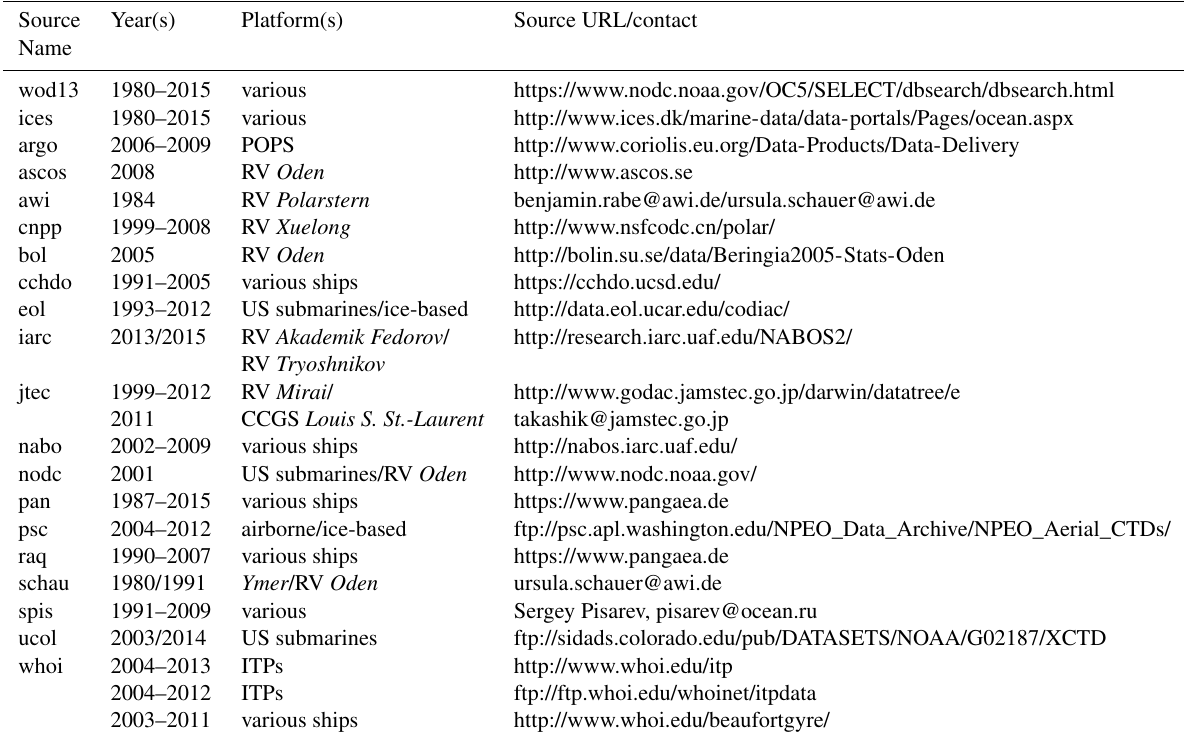
Table 1. Data sources and their abbreviations used in the data files. Also shown are time periods and URLs of the downloaded data. Source